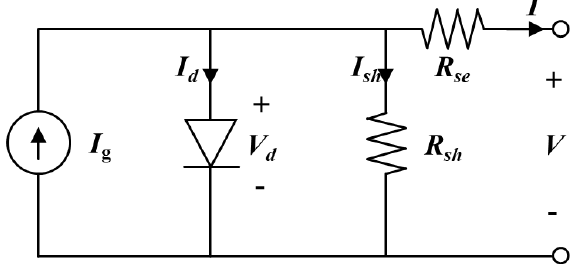
Figure 5. Equivalent Circuit of PV Panel.